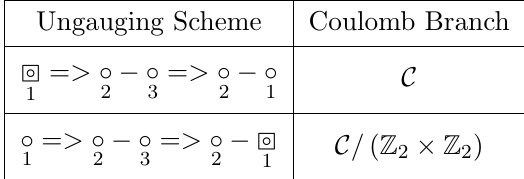
Table 9 . Transitive orbifold behavior of Coulomb branches for quiver with two non-simply laced